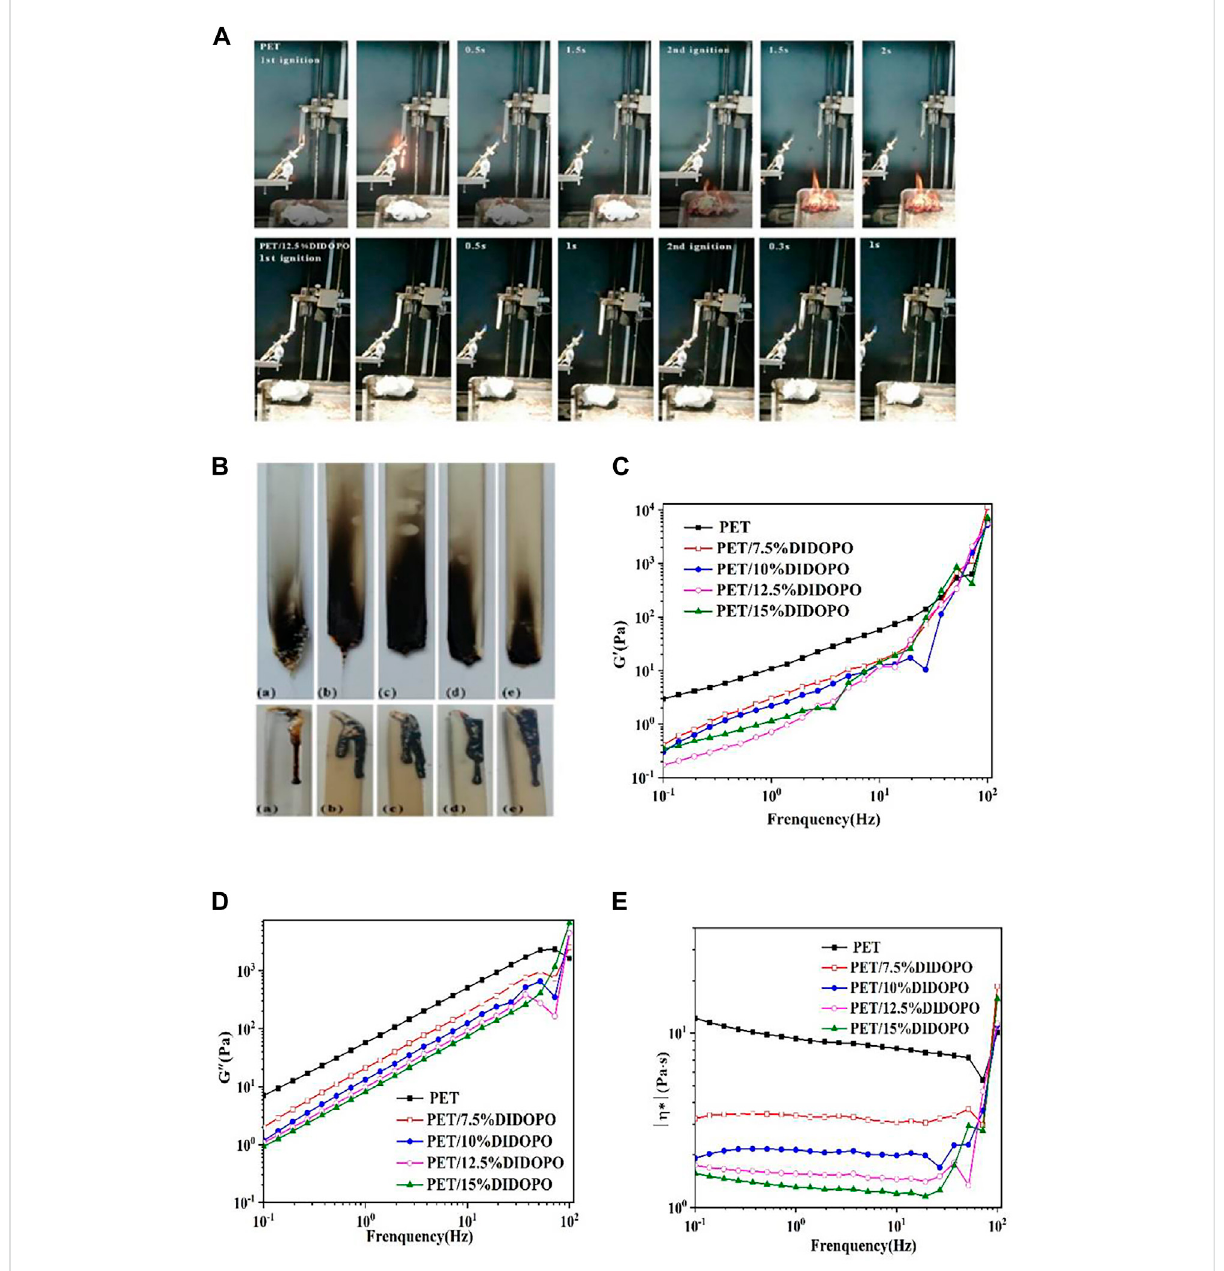
FIGURE 1 (A) UL-94 test process of PET/DIDOPO conjugated fl ame retardant composite; (B) The digital photoshops of the PET/DIDOPO samples after UL-94 tests and LOI test; Evolution of storage modulus (C) , loss modulus (D) , and complex viscosity (E) as a function of frequency for PET/DIDOPO